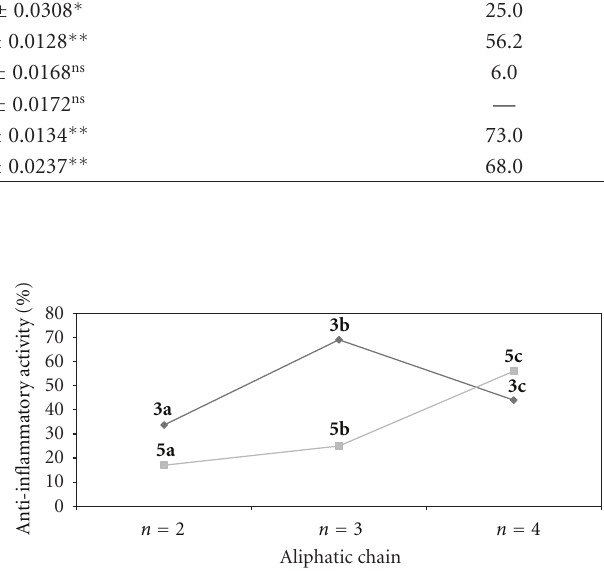
Figure 3: Analysis of anti-inflammatory activity (%) versus varia- tion of size aliphatic chain in the compounds 3a–c (CTP) and 5a–c